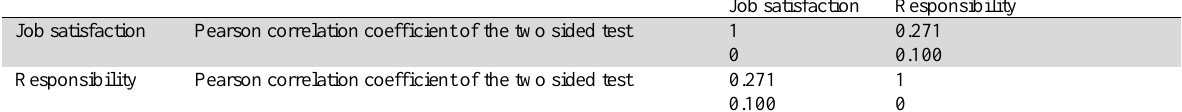
The results of Pearson correlation test for the seventh hypothesis